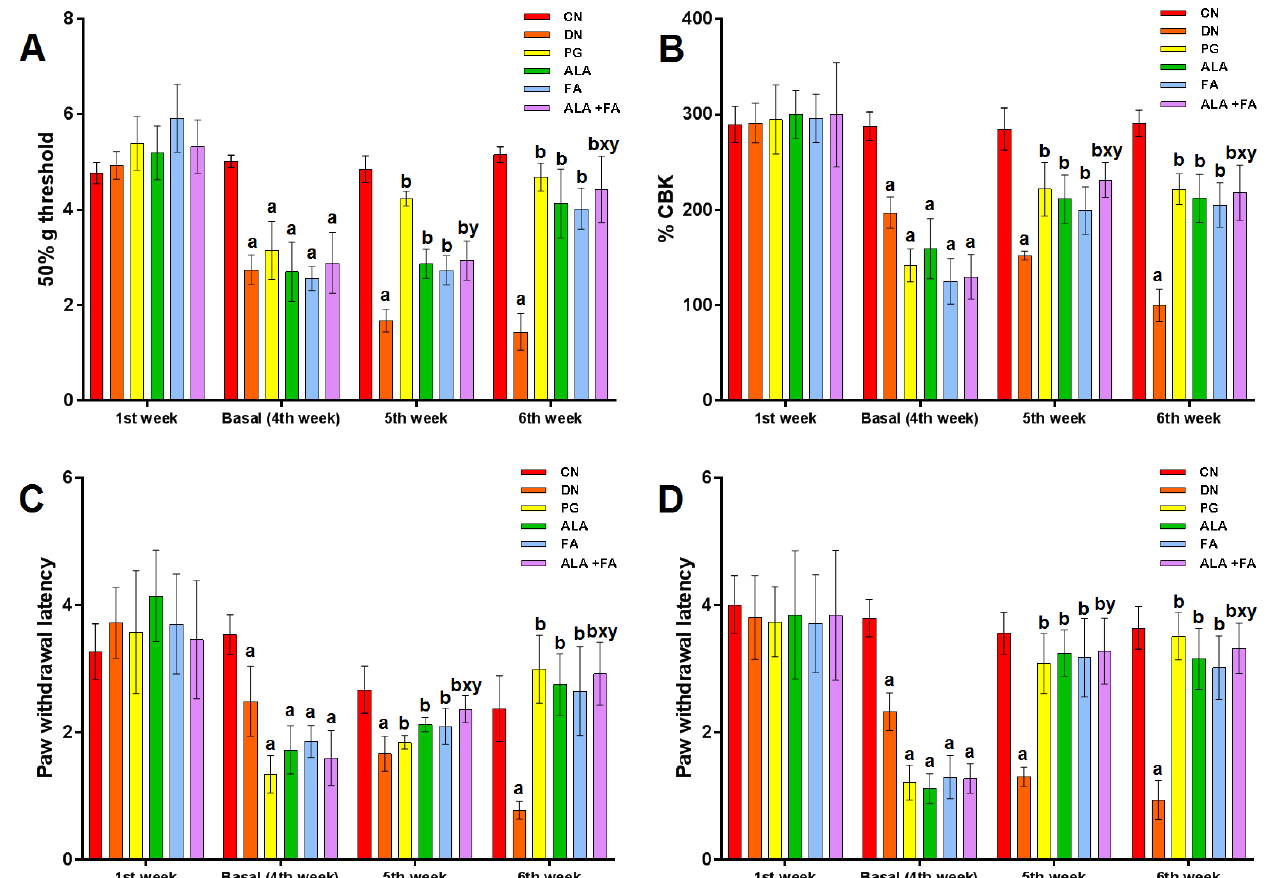
Figure 1. Effect of ALA, FA and their combination on 50% gram threshold of the left hind paw (A) and paw withdrawal latency using mechanical hyperalgesia with Randall-Selittoan algesiometer (B) and Pinprick Test (C), in addition to cold allodynia using acetone (D)in diabetic neuropathy induced rats. P<0.05 compared using Dunnet ‘t’ test, Control compared with diabetic neuropathy b treatments (ALA/FA) , group treated with a combination of antioxidants were compared with ALA y